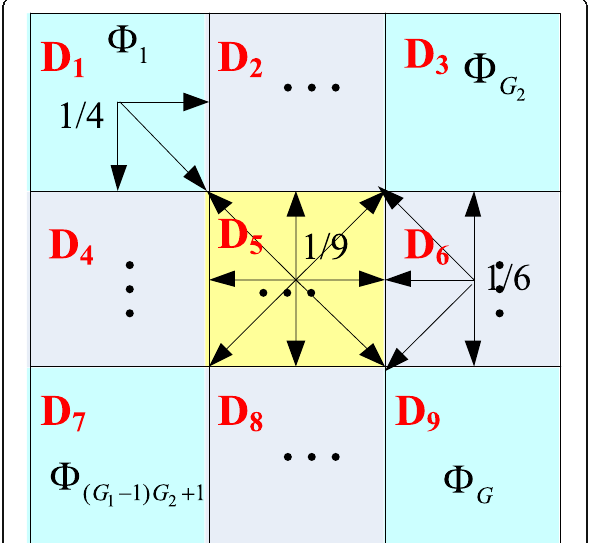
Fig. 3 The schematic diagram of